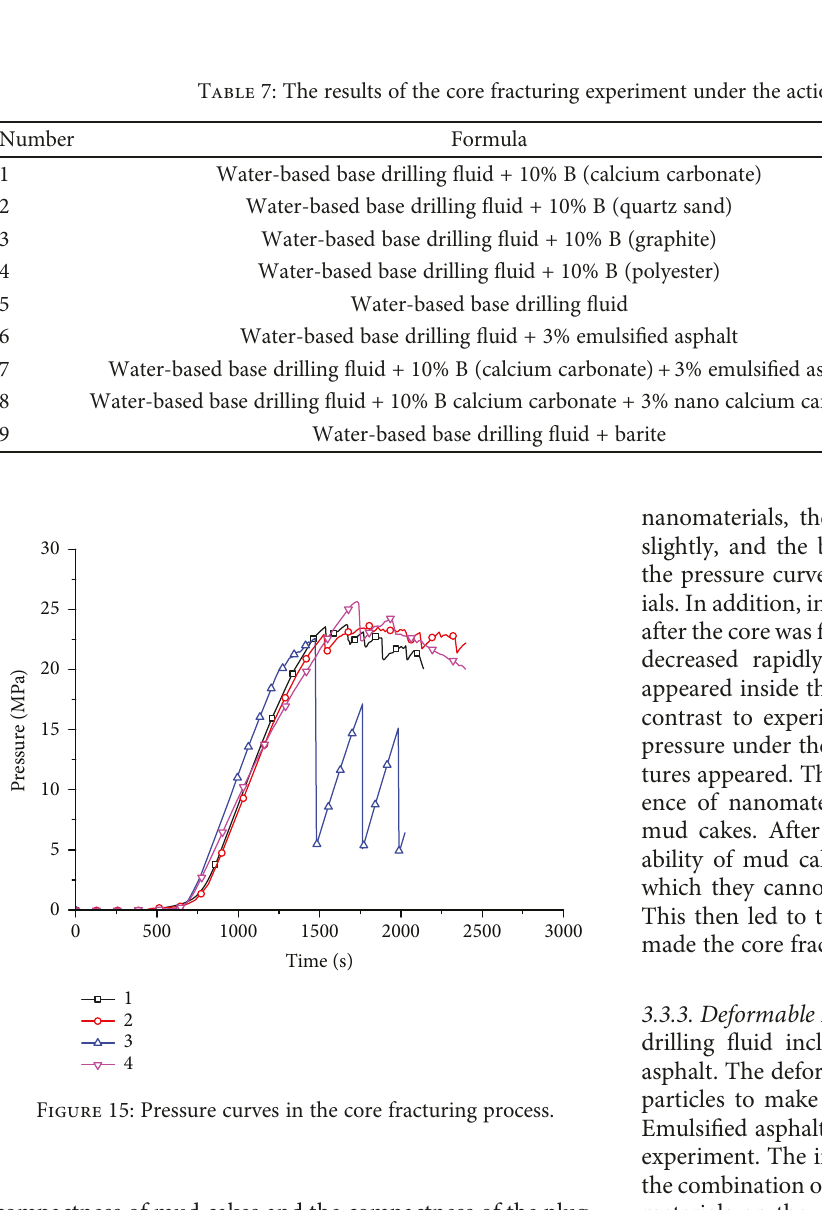
Figure 14: The removed core with microfractures on its surface.